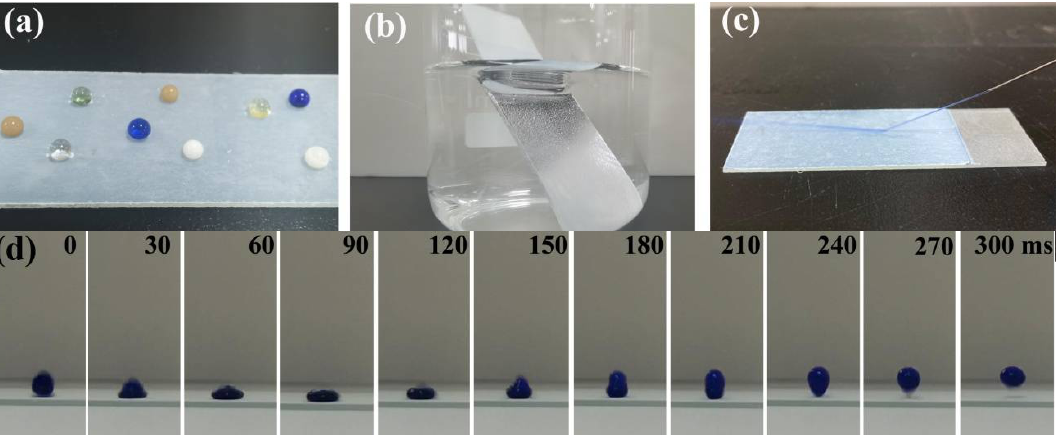
Figure 6. ( a ) Photographs of the non-wetting of common droplets (milk, coffee, green tea, water and ink) on superhydrophobic coatings, ( b ) silver-mirror-reflection phenomenon of superhydrophobic coating soaked in water, ( c ) photograph of a stream of water jumping on the superhydrophobic coating, and ( d ) the images illustrate a water droplet (R 0 ≈ 3mm) bouncing on the coating. Time interval is 30 ms.